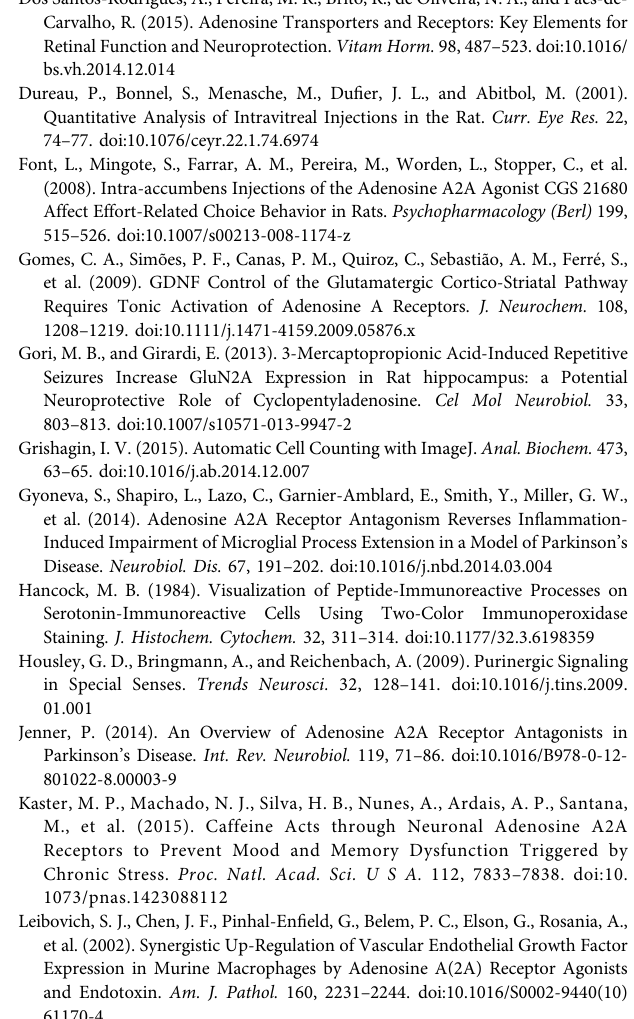
SUPPLEMENTARY FIGURE S1 | qRT-PCR for A2A receptor in retinas from CGS 21680 treated eyes and their respective CTL. Primers A2A: Forward CGGGAACTC CACGAAGACC Reverse AGCAAAGAGCCCGACGATG. Boxes represent 25 and 75 percentiles, whiskers represent minimum and maximum values and transverse lines represent means. SUPPLEMENTARY FIGURE S2 | qRT-PCR for A2A receptor in retinas from SCH58261 treated eyes and their respective CTL. Primers A2A: Forward CGGGAA CTCCACGAAGACC Reverse AGCAAAGAGCCCGACGATG. Boxes represent 25 and 75 percentiles, whiskers represent minimum and maximum values and transverse lines represent means. Student ’ s t test, * P < 0.05. SUPPLEMENTARY FIGURE S3 | Left. Representative section of a retina treated with SCH58261 and the corresponding control. Observe the lower number of apoptotic nuclei in ONL. Right: Representative section of a retina treated with CGS21680 and the corresponding control. PRL, photoreceptor layer; ONL, outer nuclearlayer;OPL,outerplexiformlayer;INL,inner nuclearlayer,IPL,innerplexiform layer; GCL, ganglion cell layer. Scale bar: 20 μ m. SUPPLEMENTARY FIGURE S4 | Top. Western blot membranes of retinas from CGS21680-treated and CTL eyes. From top to bottom, the bands correspond to activated caspase-3, GFAP and actin. B. Bottom. Western blot membranes of retinas from SCH 58261-treated and CTL eyes. From top to bottom, the bands correspond to activated Caspase-3, GFAP and actin.